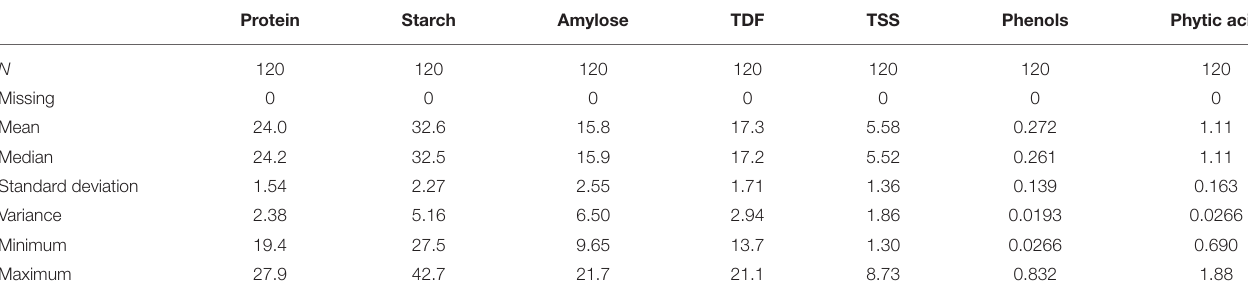
TABLE 1 | Descriptive statistics of 120 COWPEA germplasm for seven biochemical traits. Protein Starch Amylose TDF TSS